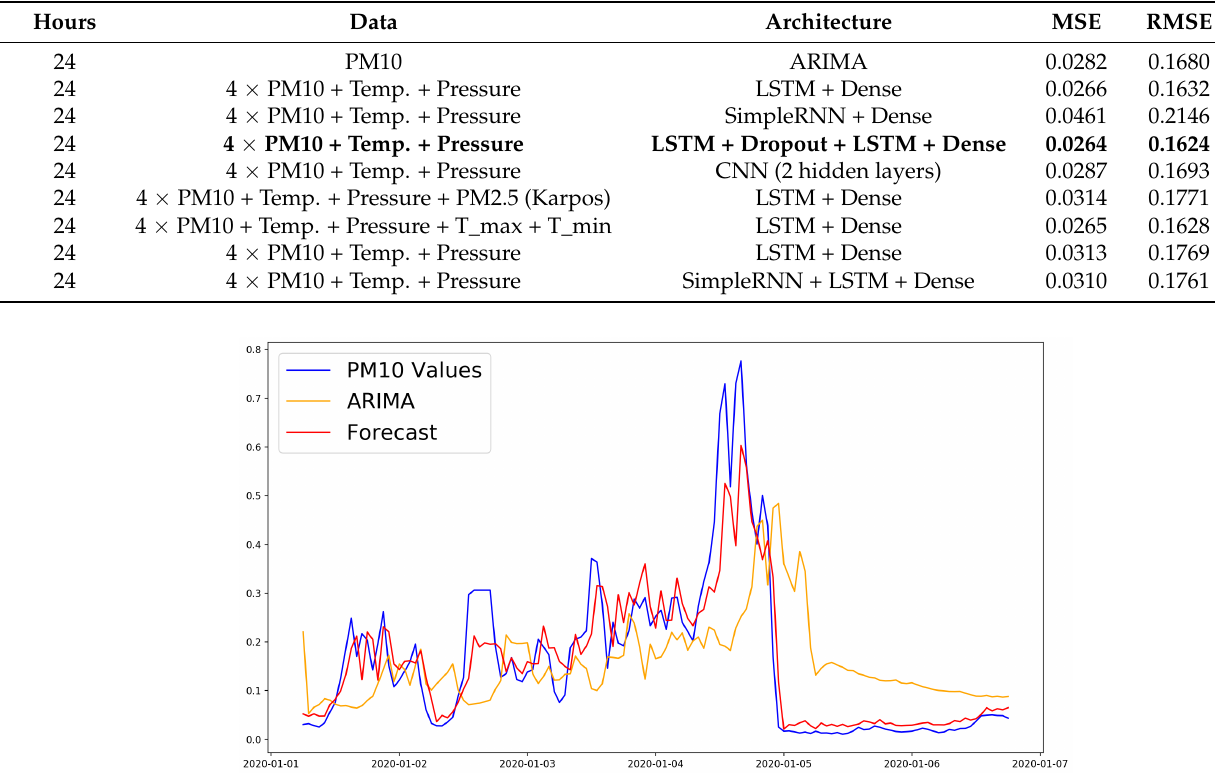
Figure 3. Performance comparison to the ARIMA model of the RNN + Dense model with the best forecasting performance with the 6 h time horizon. For the twelve hour time horizon, most of the proposed approaches were better compared to the baseline ARIMA model (MSE, RMSE): (0.0266, 0.1631). The best model used the “LSTM + Dense” architecture and combined the PM10 measurements with the temperature, pressure, and PM2.5 measures (MSE, RMSE): (0.0151, 0.1227). The results